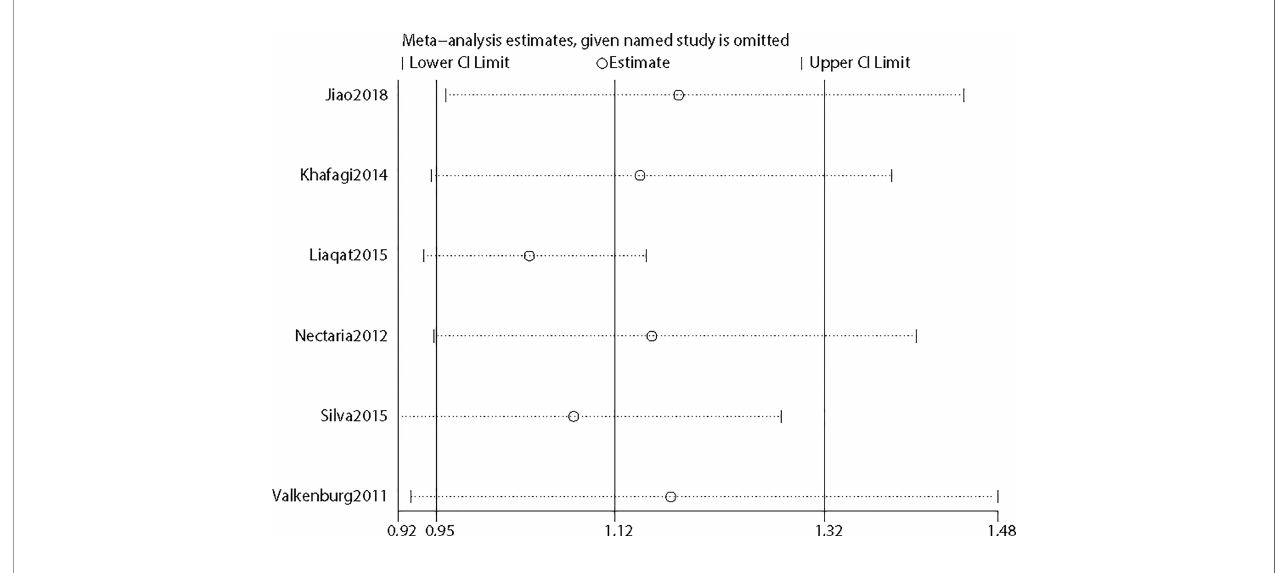
FIGURE 5 | Sensitivity analysis of the included studies.